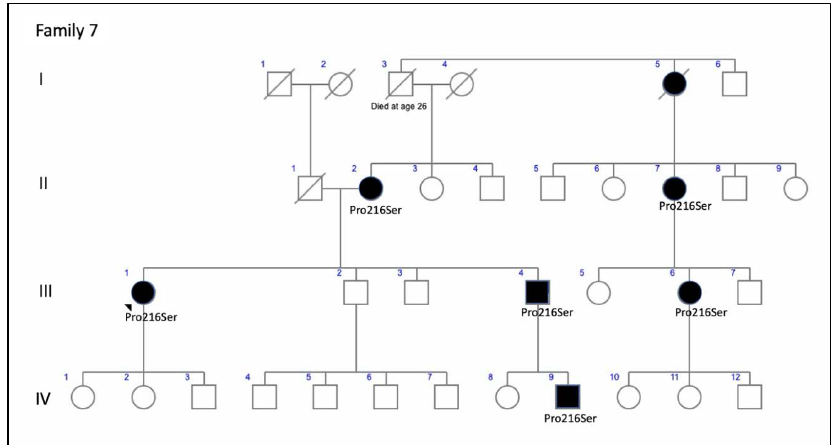
Figure 16. The family 7 pedigree shows a clear autosomal-dominant family tree.